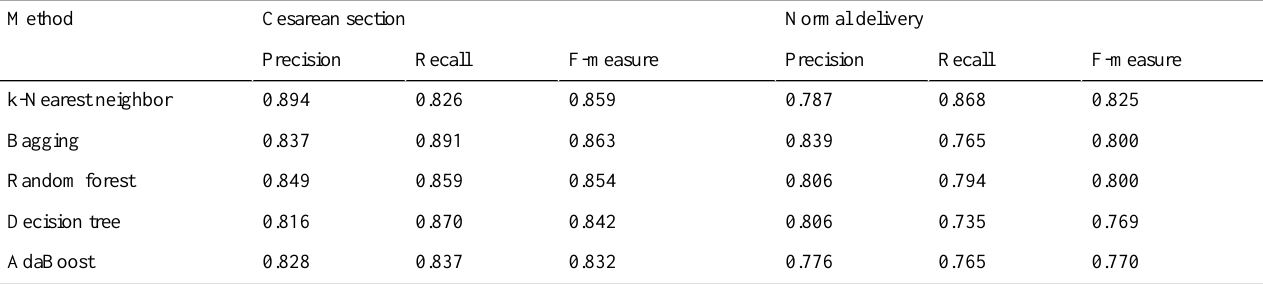
Normal deliveryCesarean